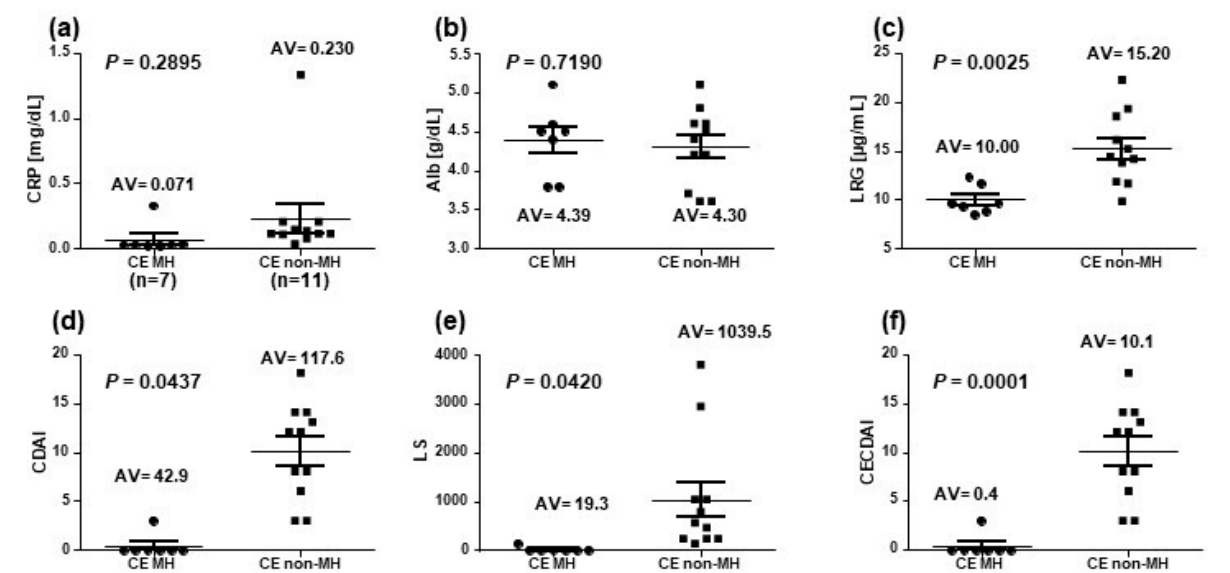
Figure 3. Connection between Crohn’s disease activity markers and mucosal healing in capsule endoscopy. ( a ) CRP, ( b ) Alb, ( c ) LRG, ( d ) CDAI, ( e ) LS, and ( f ) CECDAI were determined in the CE-MH group (n = 7) and CE-non-MH group (n = 11); P - value is the result of comparing two groups by the two-tailed t-test.